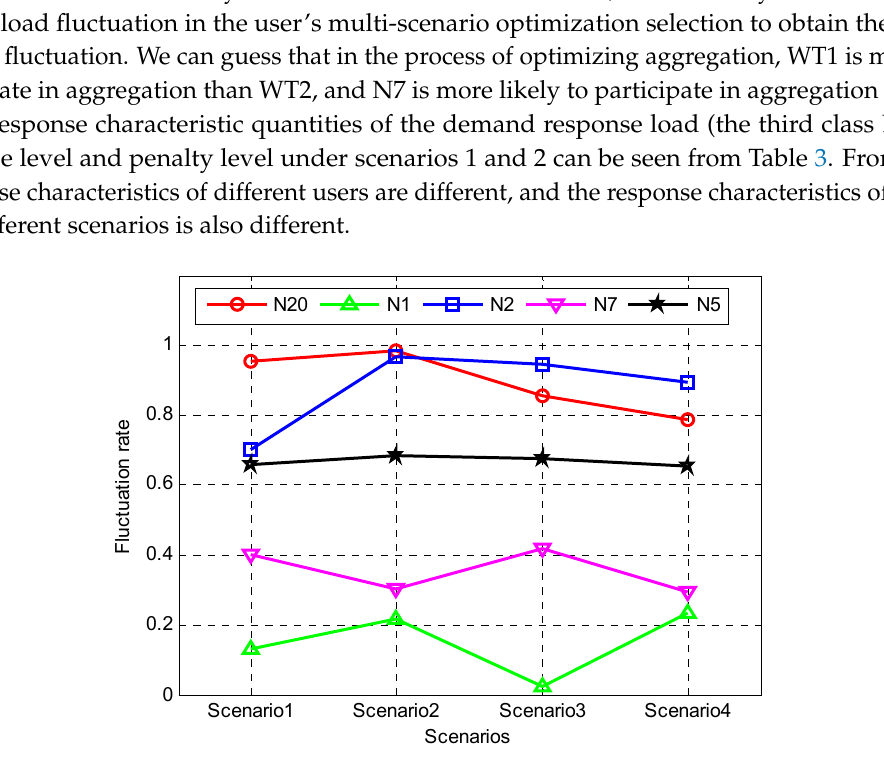
Figure 10. The distribution of user load fluctuation under different scenarios.